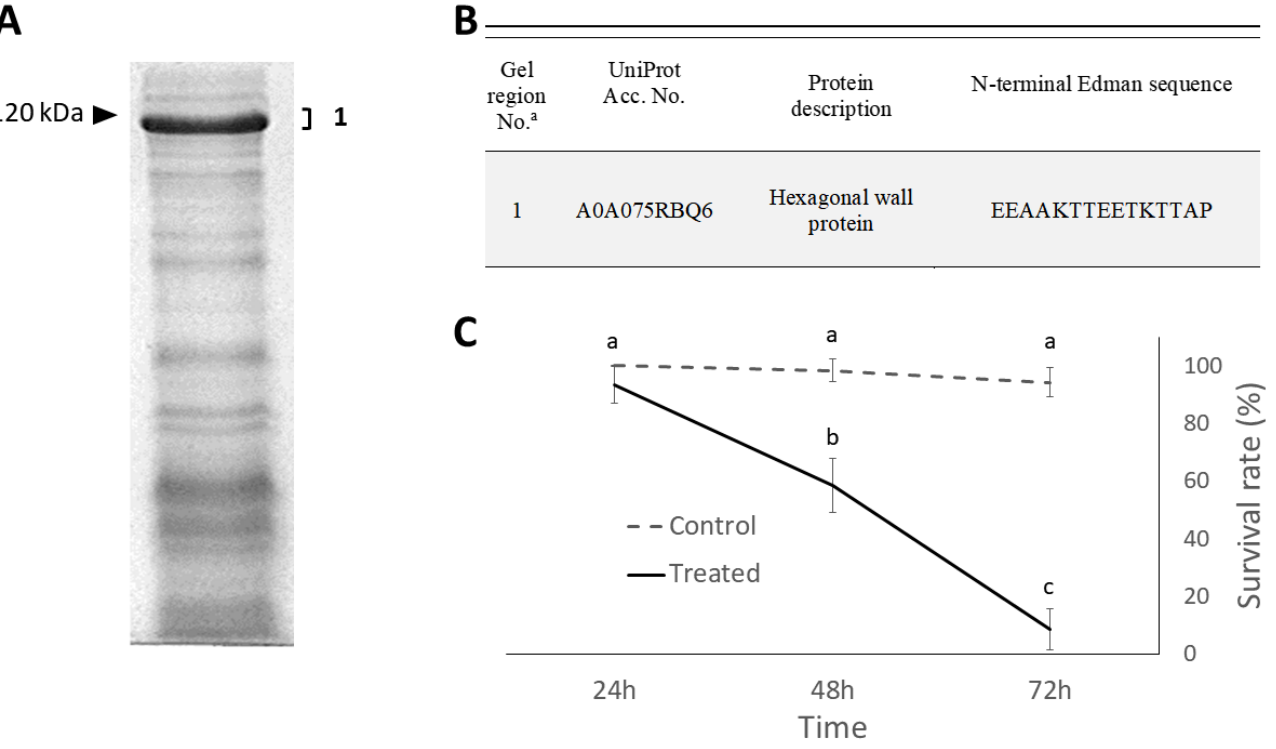
Figure 3. Protein profile and virulence of the whole sporulated culture of B. laterosporus . ( A ) SDS- PAGE showing a major band just below 120 kDa. ( B ) Identification of the main protein band by N-terminal sequencing. ( C ) Over time survival (mean ± SD) of house fly adults treated with the whole sporulated culture. Different letters indicate significantly different means (ANOVA proc. mixed, least square means (LSMEANS) adjust = Tukey, p < 0.001). “a” indicate gel regions excised from 1-DE gel for Mass Spectrometry analyses numbers “1, 2, and 3” indicate the specific gel region excised from the gel.